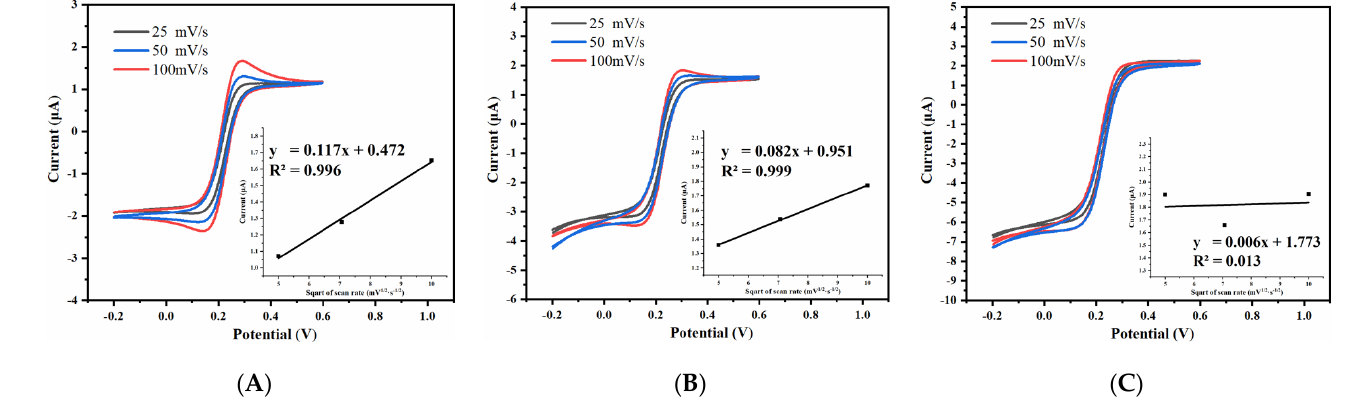
Figure 10. Cyclic voltammogram and the relationship between the oxidation peak current and the square root of scanning (inset) of UIAE with different widths: ( A ) 15 μ m; ( B ) 10 μ m; ( C ) 5 μ m.